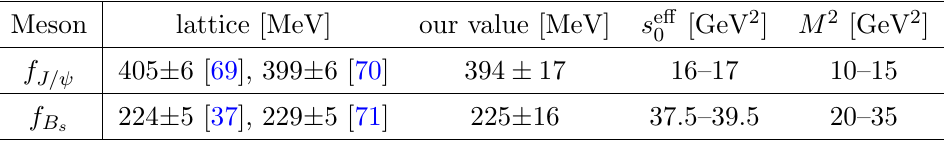
Table 7 . Decay constants of mesons with 3ptSR